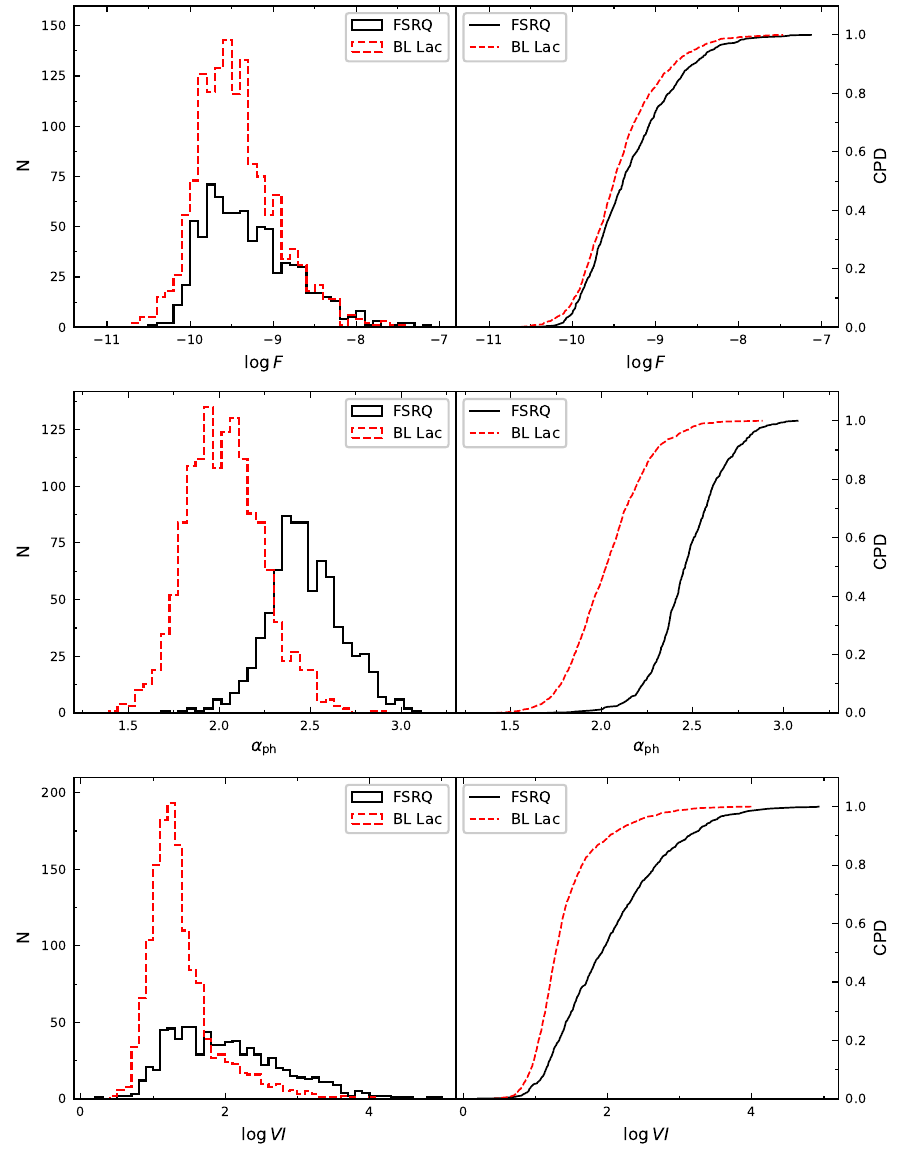
Figure 1. Histograms ( left panel ) for FSRQs and BL Lacs and their corresponding cumulative probability distribution (CPD, right panel ) for three parameters. In this plot, the dashed red line for the BL Lacs and the solid black line for the FSRQs. Upper panel : for logarithm of the γ -ray photons, log F in units of ph/cm 2 /s, middle panel: for the γ -ray photon spectral index, α ph , bottom panel : for logarithm of the γ -ray variability index, log VI , Photon Spectral Index- α ph : We show the distributions of α ph for FSRQs and BL Lacs in the middle-left panel in Figure 1, and their cumulative distributions are shown in the middle-right panel of Figure 1. The average photon spectral indexes are (cid:104) α ph (cid:105) = 2.470 ± 0.201 for 795 FSRQs and (cid:104) α ph (cid:105) = 2.032 ± 0.212 for 1432 BL Lacs. The K-S test gives p = 7.77 × 10 − 16